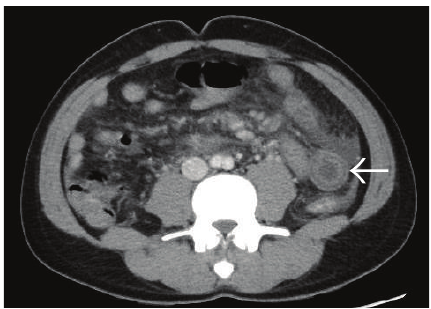
Figure 52: Axial CECT image demonstrating halo sign in one of the jejunal loops due to inner mucosal and outer muscularis propria rings of high attenuation separated by submucosal layer of low attenuation representing edema in a patient with SMV thrombosis. Extensive mesenteric stranding and minimal ascites can also be seen.